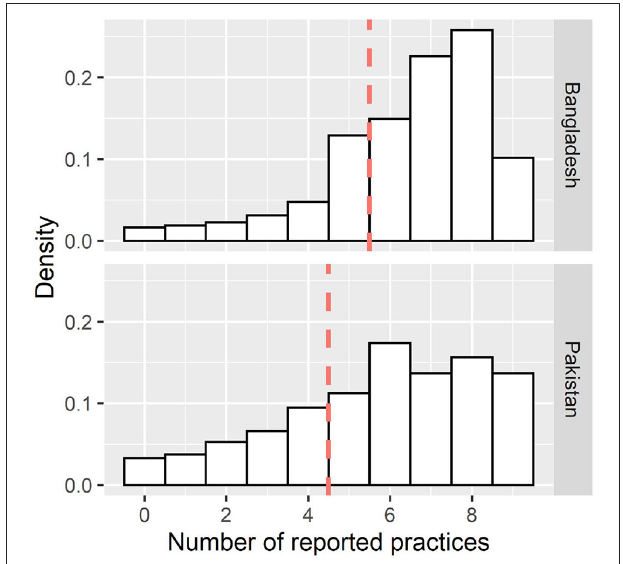
FIGURE 3 | Distribution of the number of reported practices (out of nine) to reduce the spread of COVID-19. The dashed line represents the cut off to determine “poor” practice (lower 25% of the